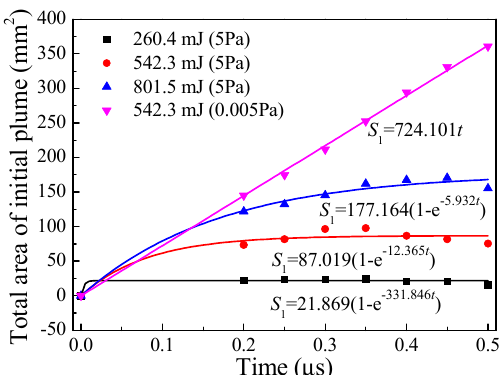
Figure 21. The total plume area variation with time at different energies (ambient pressure 5 Pa and 26.5% Al).